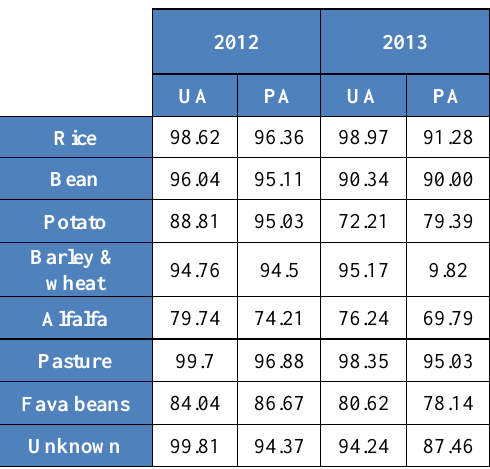
Table 2: User and producer accuracies for the full parameters case